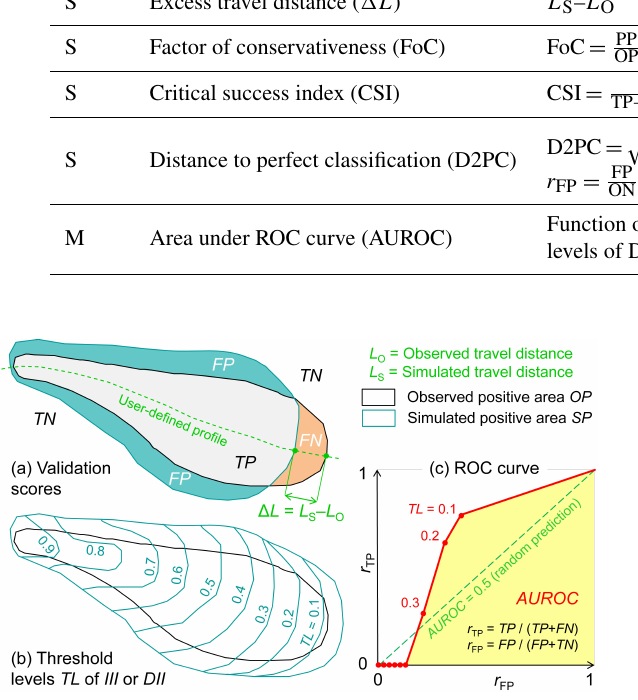
Figure 4. Validation of r.avaflow results. (a) Validation scores for single model run; (b) multiple model runs: threshold levels of III or DII, employed to produce (c) ROC